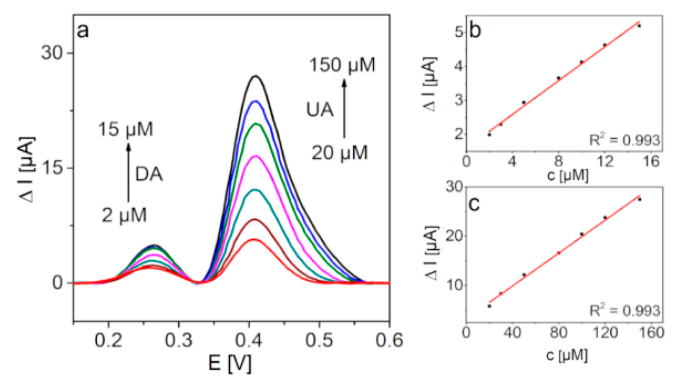
Figure 8. ( a ) DPV curves for the simultaneous detection of DA and UA recorded with GCE / PFSG in 0.1 M PBS (7.0), and ( b , c ) show the corresponding calibration plots.